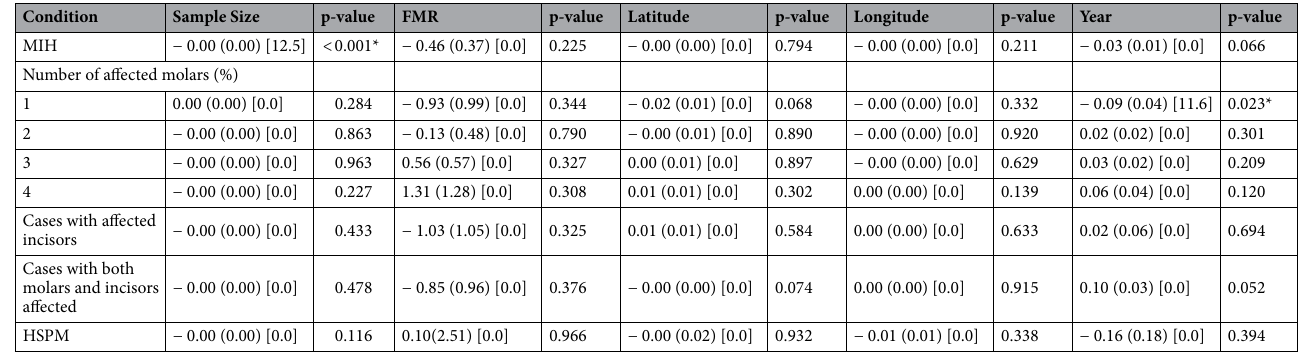
Table 4. Meta-regression analyses on the effect of female/male ratio (FMR), latitude, longitude and year. Values are provided as estimate (Standard Error) [Variance explained (%)]. MIH